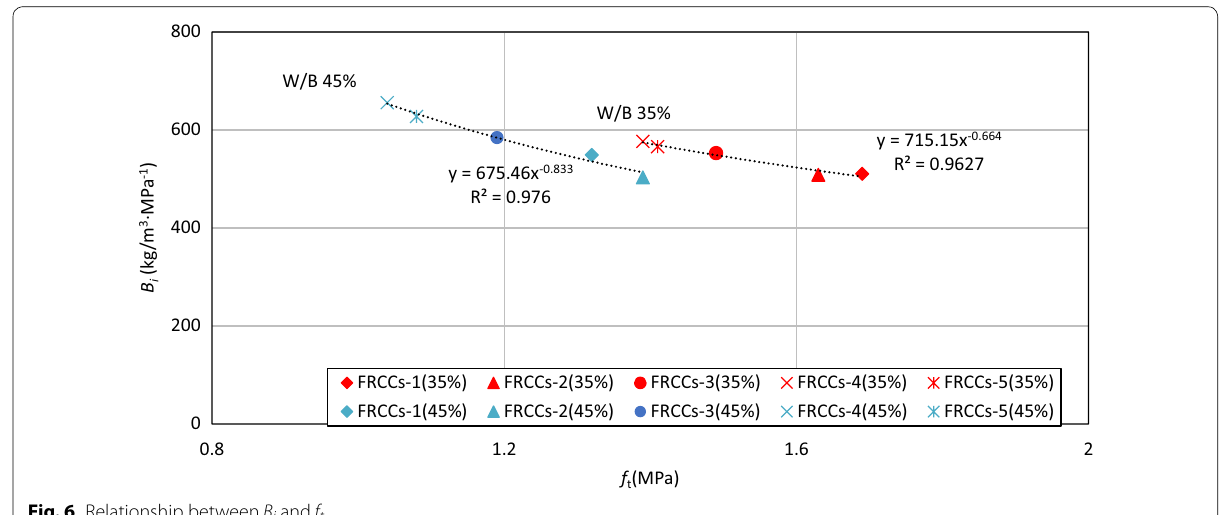
Fig. 6 Relationship between B i and f t .